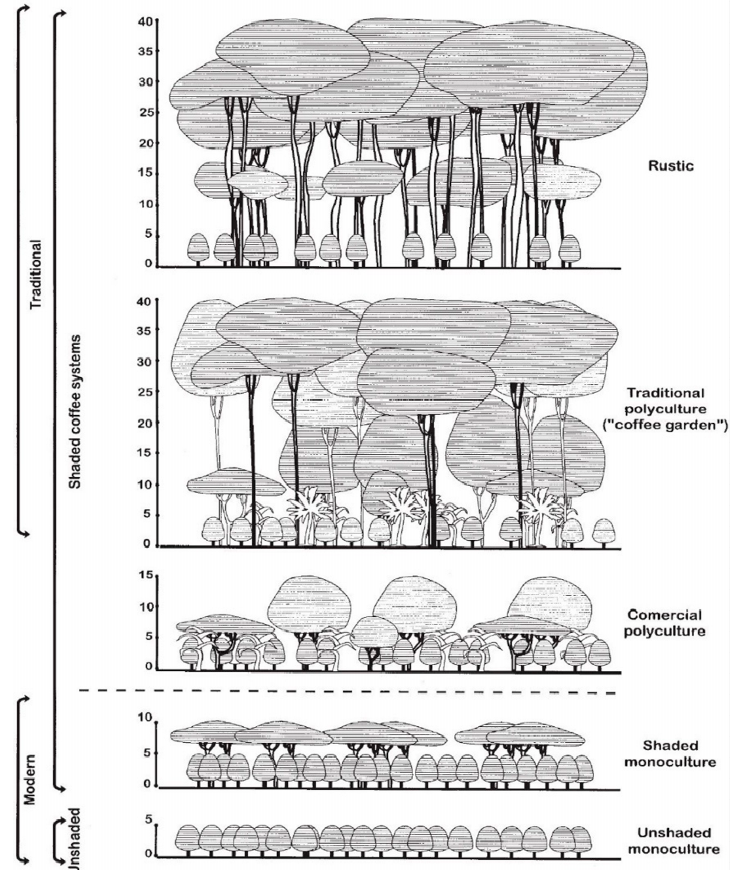
Figure 1. The figure from Moguel and Toledo [34] illustrates the canopy structure of five common coffee production systems, including four shaded coffee systems (shaded monoculture, commercial polyculture, traditional polyculture, and rustic) and unshaded monoculture.